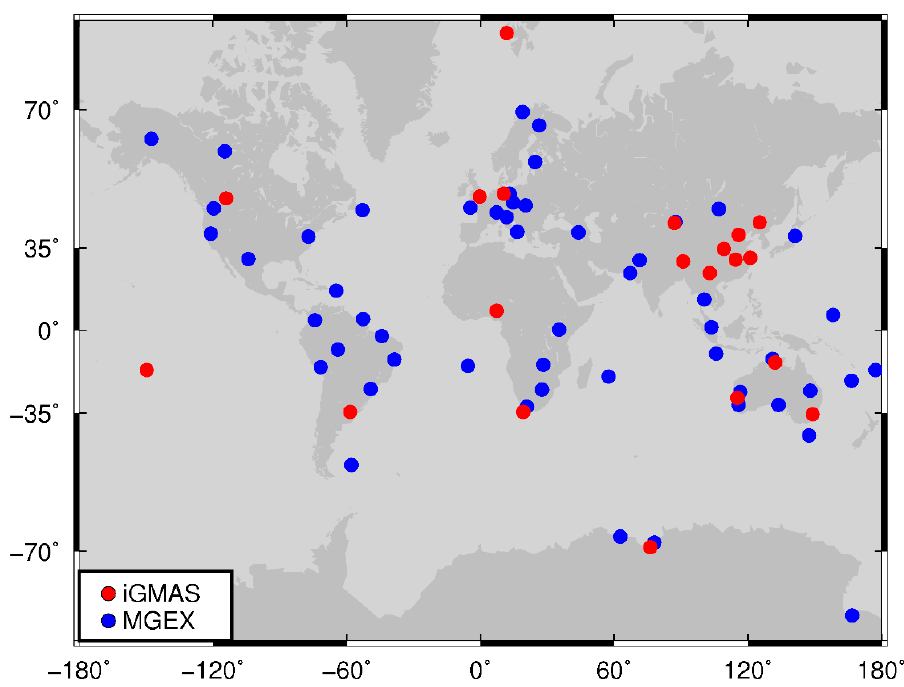
Figure 1. Distribution of 80 MGEX (blue dot) and iGMAS (red dot) stations.